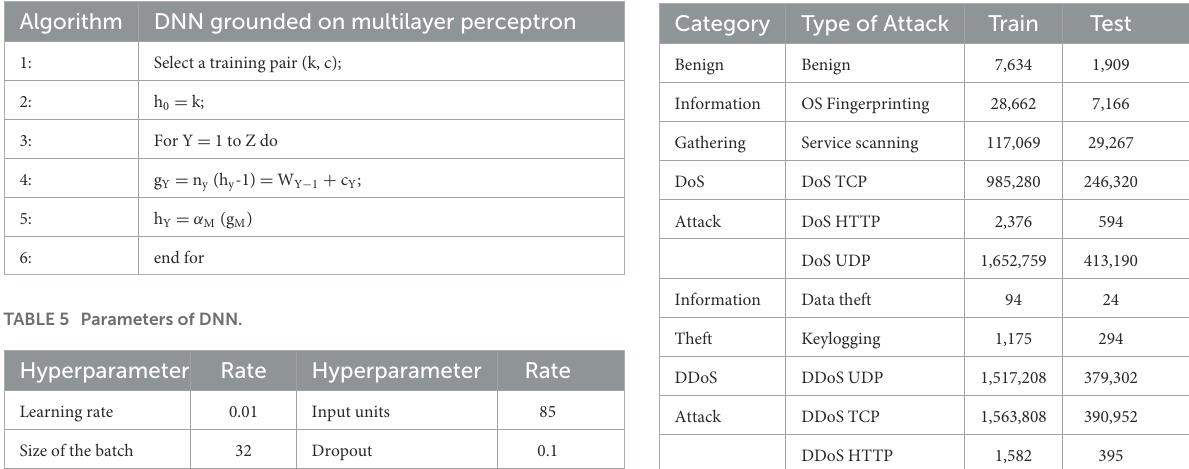
TABLE 7 Attack distribution in Bot-IoT